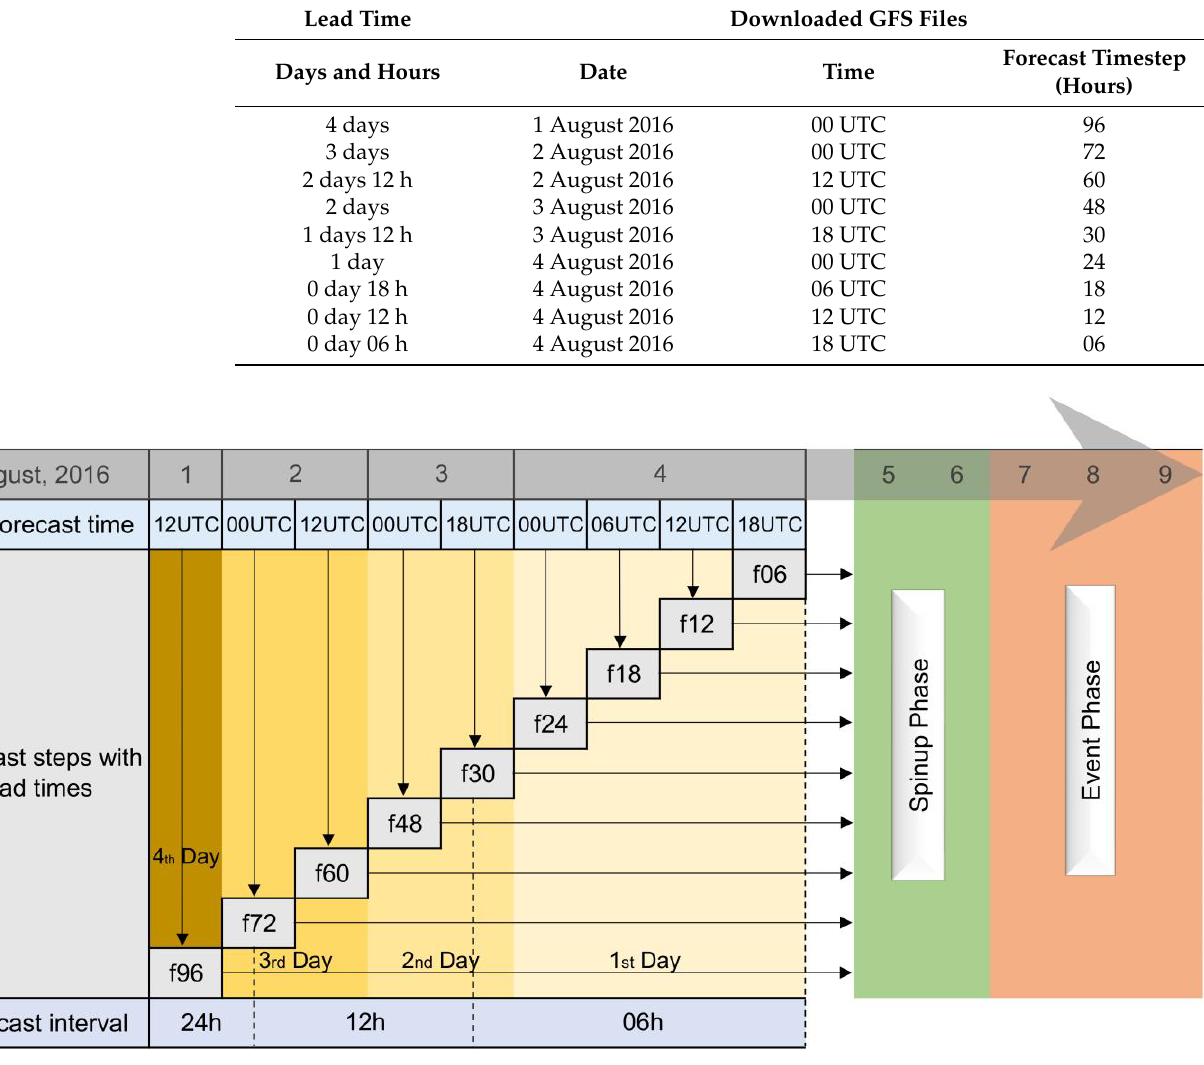
Table 2. Download pattern of GFS forecast files for the selected peak event in the CRB.